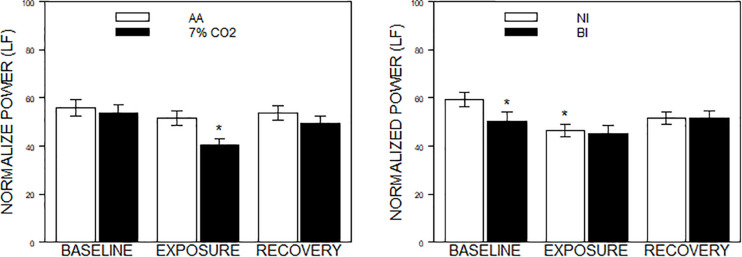
Normalized power in the frequency domain as a function of 7% CO2 exposure and temperament. The panels depict measures of normalized power from the HF and LF domains across the three experimental phases. Normalized LF was used for the analysis, but note that LF and HF are reciprocal. The legend for each panel is contained within the panel. The left panel depicts the Exposure × Phase interaction in which normalized LF power decreased during 7% CO2 exposure which recovered with reintroduction of AA. ∗ indicate p < 0.05 compared to both baseline values and AA during Exposure. The right panel depicts the BI × Epoch interaction. ∗ indicate differences relative to the baseline phase, p < 0.05. Normalized LF was initially lower in BI than NI. Over participation in the experiment (e.g., computerized task), LF reduced in NI to the levels of BI.